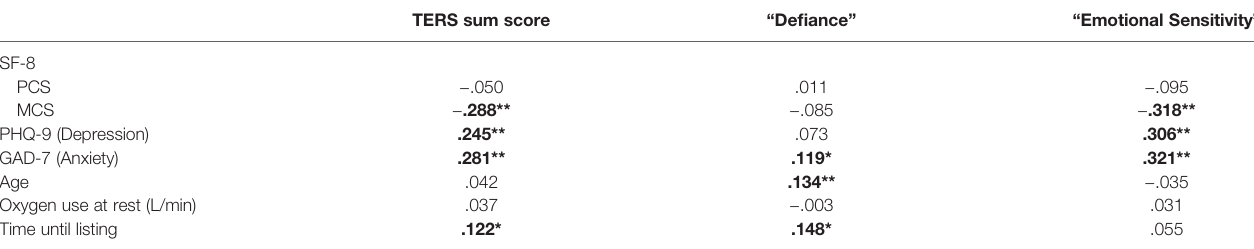
TABLE 3 | Relationship between the TERS and its two factors and measures of health-related quality of life, levels of depression and anxiety, sociodemographic parameters and measures of disease